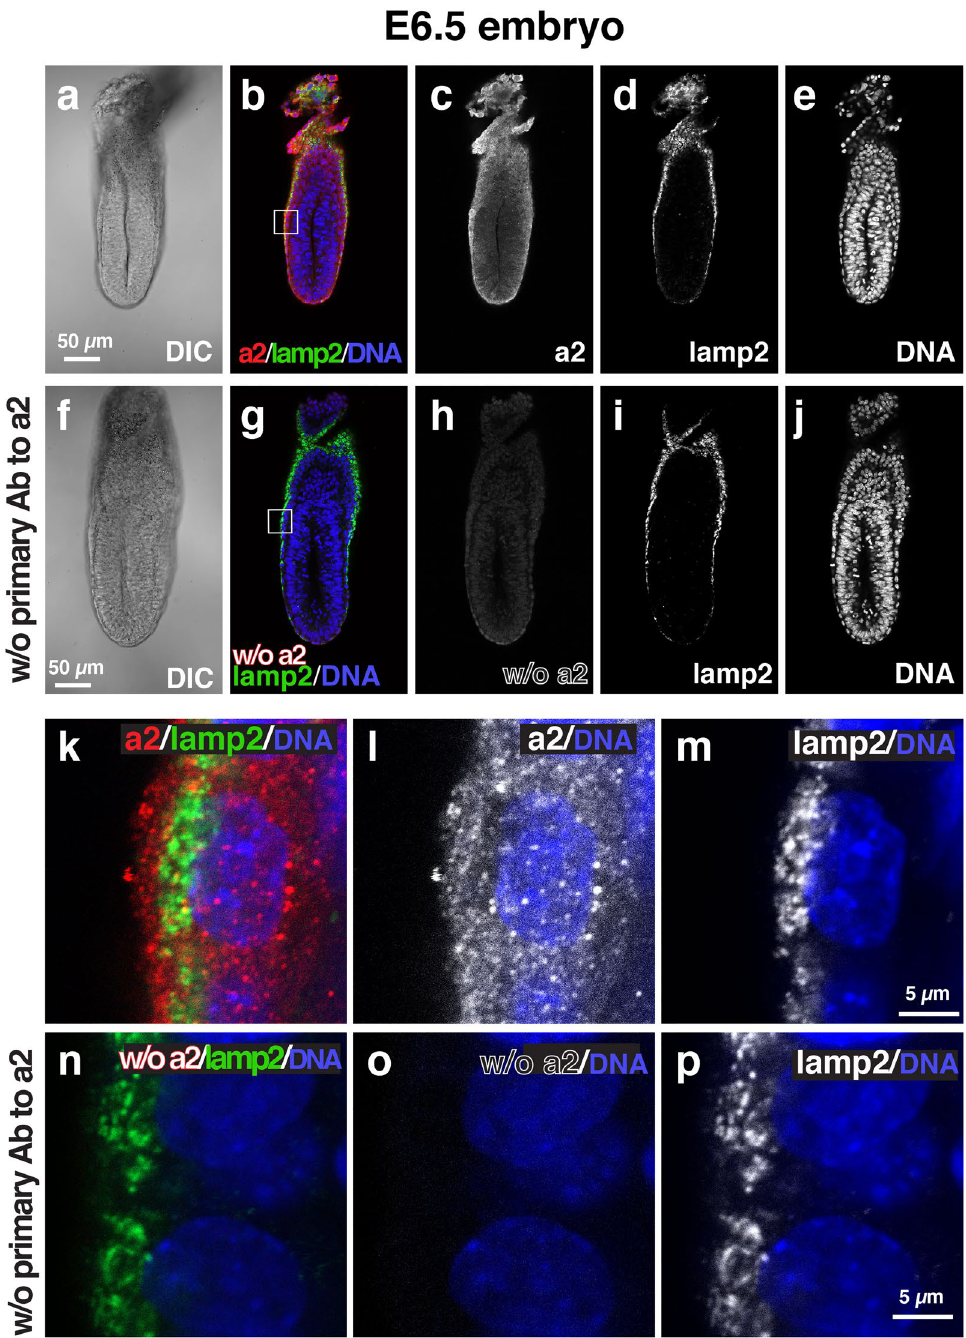
Figure 3. Localization of a2 subunit isoforms in mouse E6.5 embryos. Wild-type E6.5 embryos (n = 9) were isolated and stained with antibodies against a2 (red) and lamp2 (green). Nuclear DNA is also labelled (blue). The control embryos (n = 4) labelled without the primary antibody against a2 (w/o primary Ab to a2) was shown in ( f – j , n – p ). The secondary antibody alone controls in which the embryos were labelled without primary antibodies against the a2 isoform were performed in parallel and the images were obtained under the same microscopic setup. The boxed region in ( b , g ) is magnified and shown as ( k – m , n – p ), respectively. Scale bars represent 50 µm and 5 µm in ( a – j , k – p ),